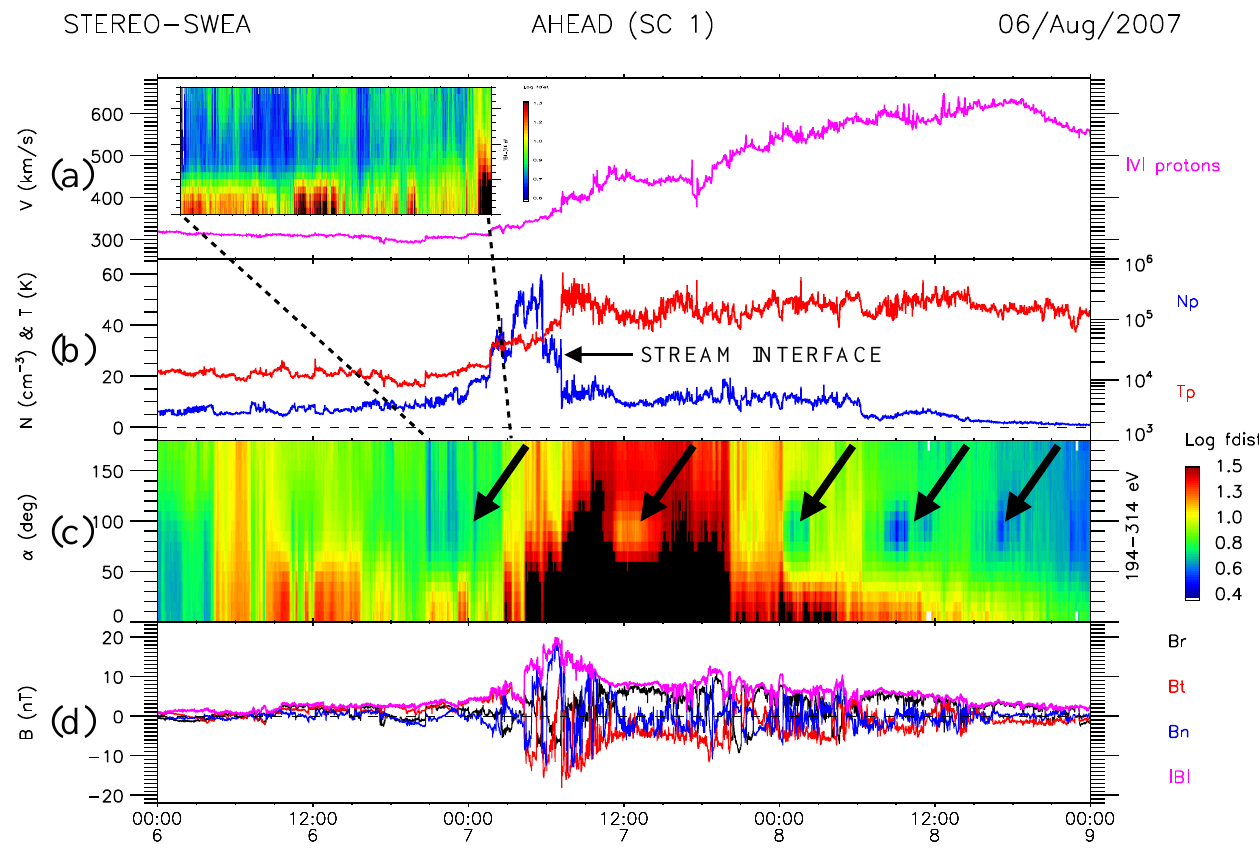
Fig. 3. Ion, electron and magnetic field data from ST-A during the passage of a CIR in August 2006 (spacecraft position was (+1973, − 5271, 45) R E in GSE, on 7 August 2007). The panels show (a) the ion bulk speed, (b) the ion density (left y-axis) and temperature (right y-axis), (c) a pitch angle-time spectrogram for ∼ 250eV suprathermal electrons, and (d) the magnetic field magnitude and components in RTN. Counter-streaming suprathermal electron patterns (CSE) are observed prior to the CIR, around the beginning of 7 August 2007 (first thick black arrow), as best displayed in the zoom-in pitch angle spectrogram insert of panel (a). CSEs are also clearly observed within (second to fourth black arrow) and after the CIR (last black arrow) in the fast solar wind. Table 1. Occurrence rate (in percent) of solar wind counter- streaming electron pitch angle distributions for each STEREO spacecraft during the solar minimum period 1 March–31 Decem- ber 2007. These are given as a function of the depletion value (i.e., relative to the ambient halo value; cf. text). Depletion